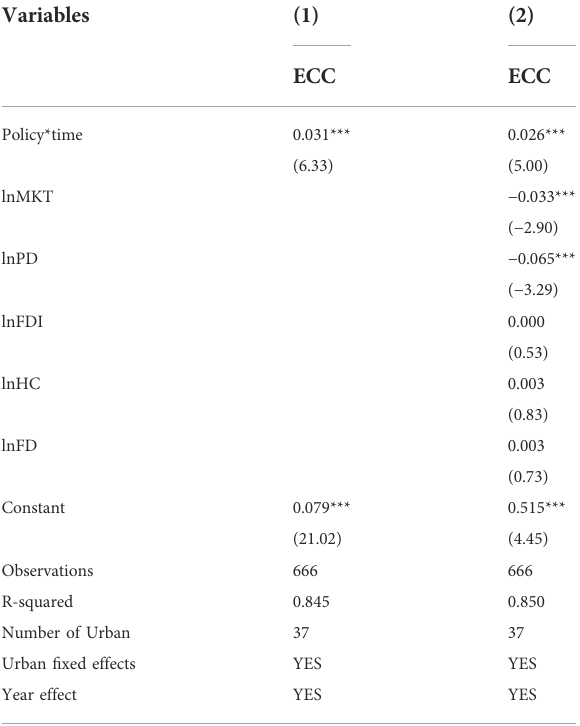
TABLE 2 Benchmark regression